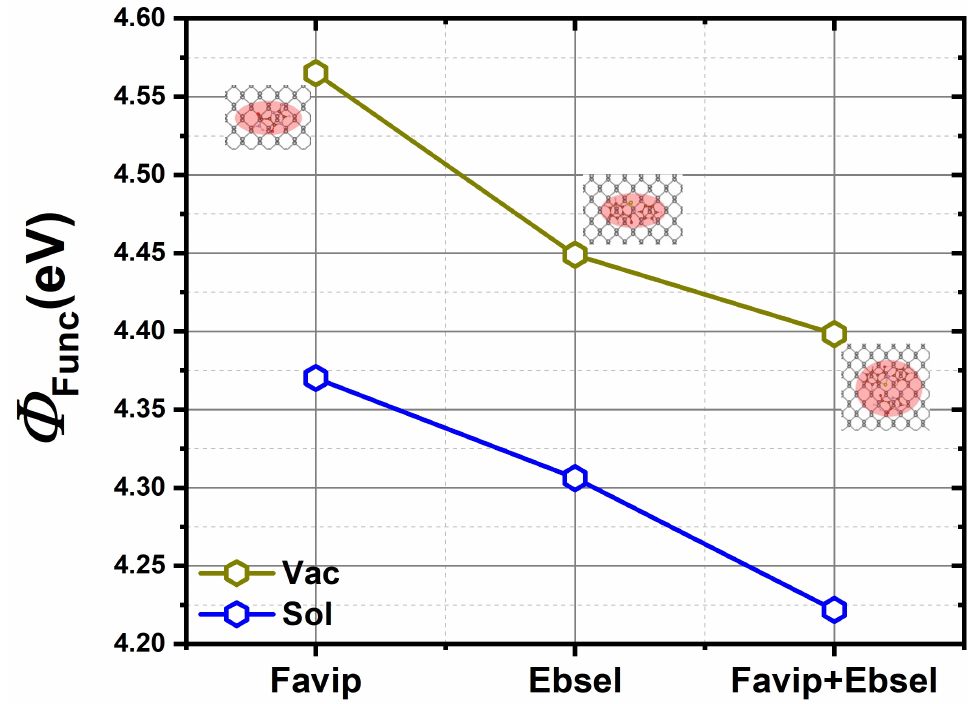
Figure 7. The calculated work function Φ in vacuum and solvent phases of BP sheet with favipiravir, ebse- len, and favipiravir+ebselen hybrid configurations in a vacuum (olive) and with solvent (blue),